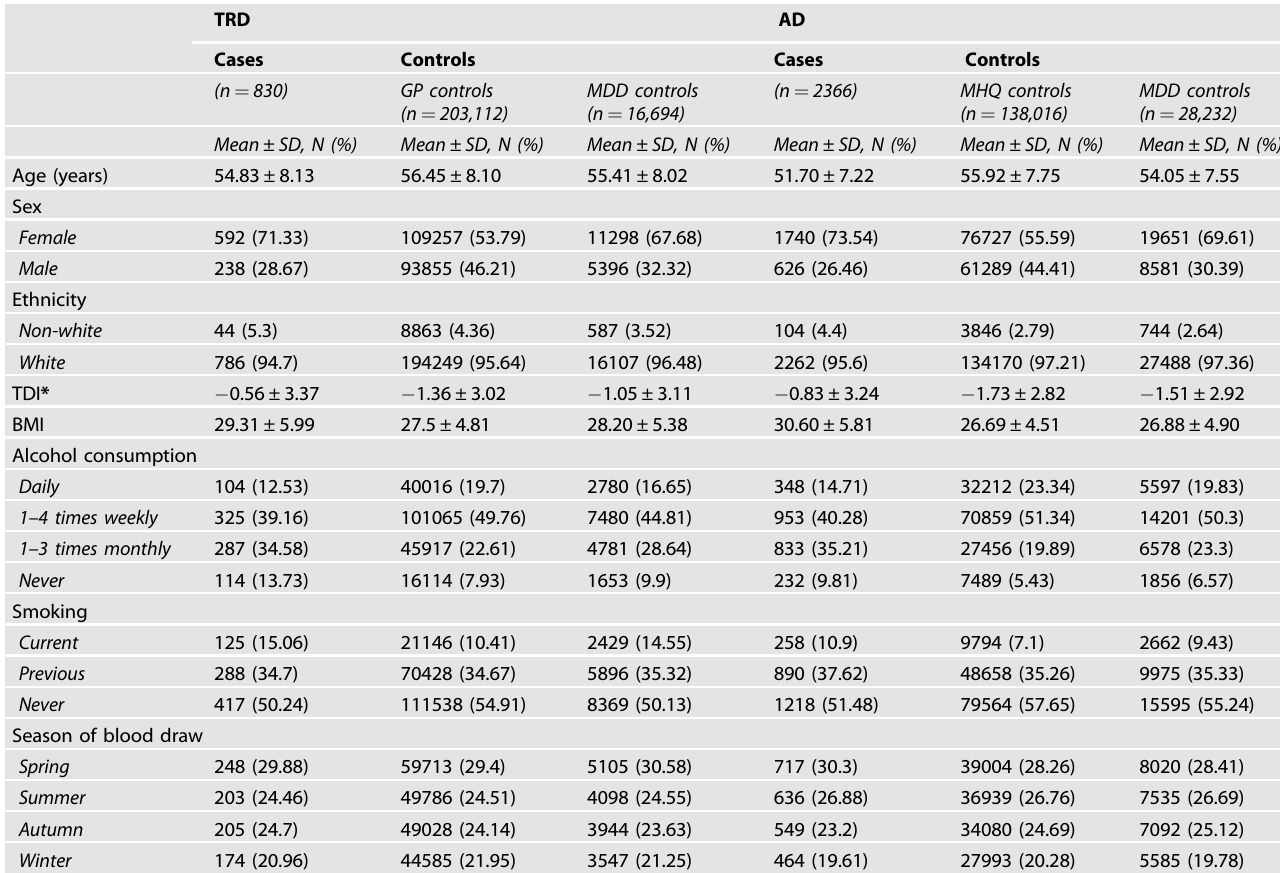
Table 1. Sample characteristics in incident treatment-resistant (TRD) cases and atypical depression (AD) cases compared to controls in observational